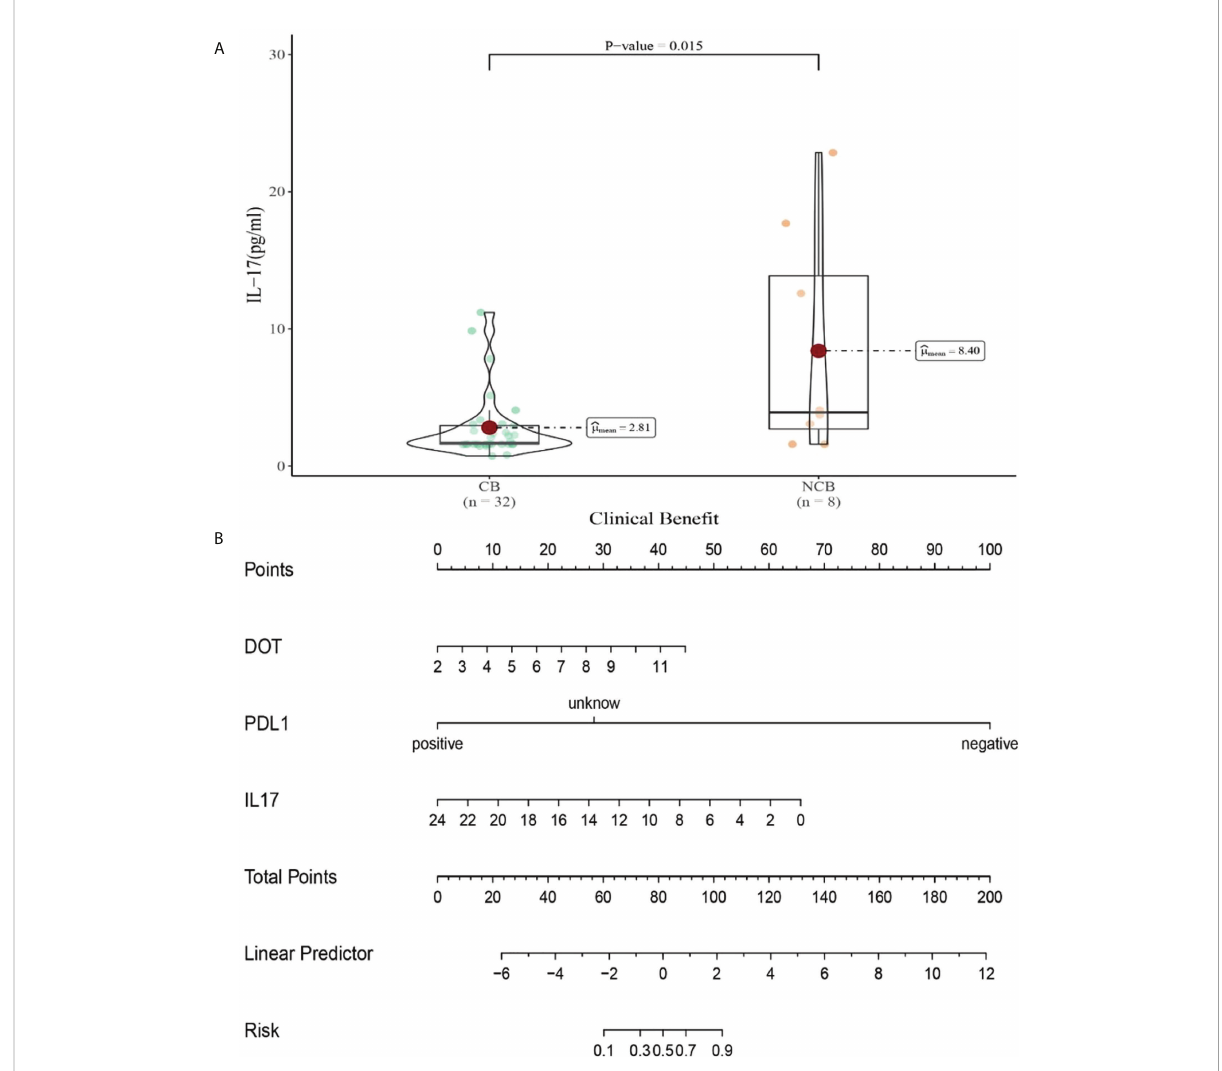
FIGURE 11 (A) Differences in IL-17 levels after the second cycle therapy between CB and UCB; (B) The nomogram based on logistic multivariate analysis.